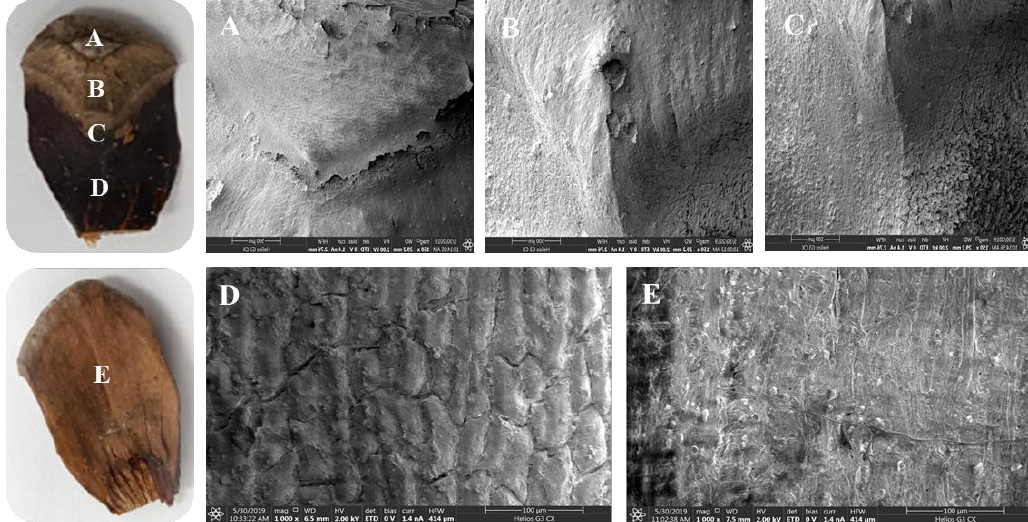
Figure 5. FE-SEM images of surface structure of dorsal ( A – D ) and ventral ( E ) cones.